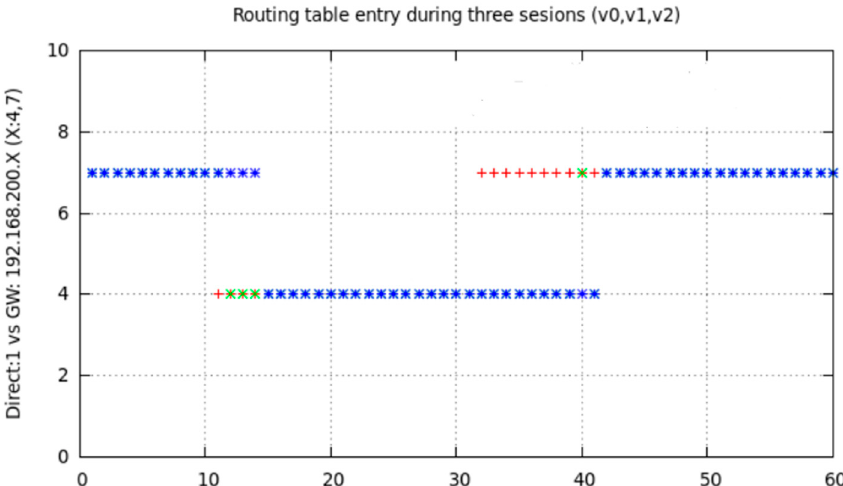
Figure 18. Chosen intermediate node for route from node6 to node1 in node6 for 3 HFT sessions of 60 s with node7 WiFi interface deactivation at t = 10 and t DOWN = 4 s.